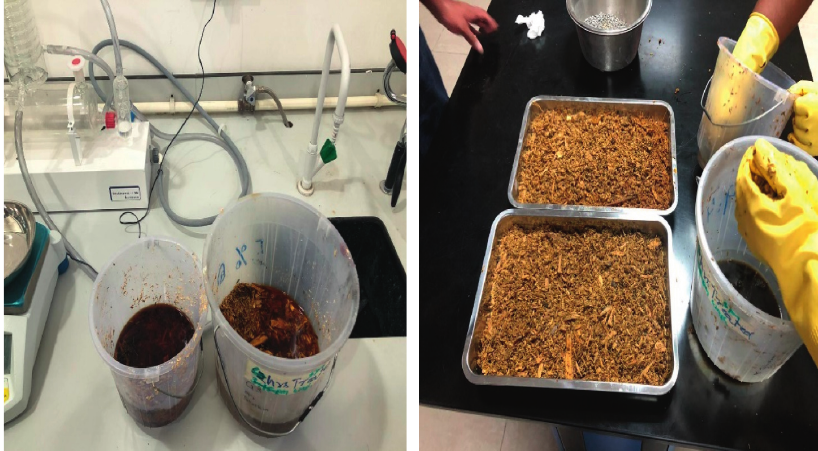
Figure 5: NaOH treatment of fibers.